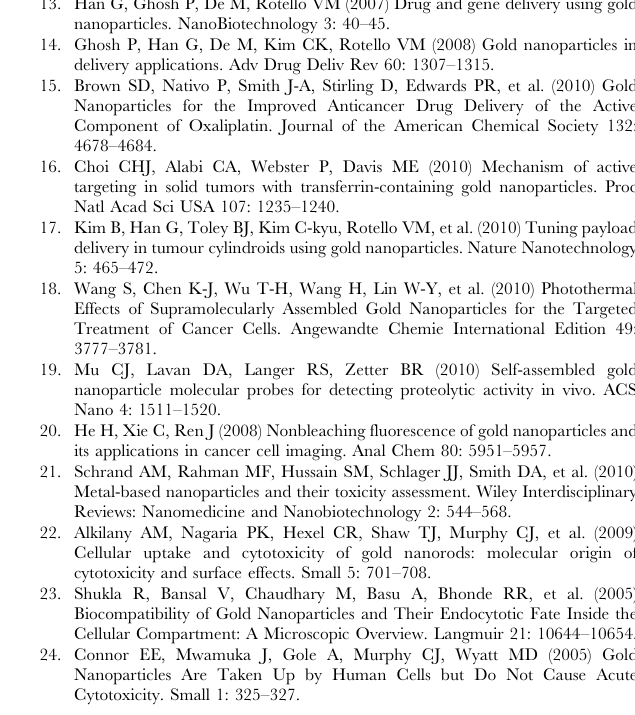
independent experiments and the error bars indicate the standard